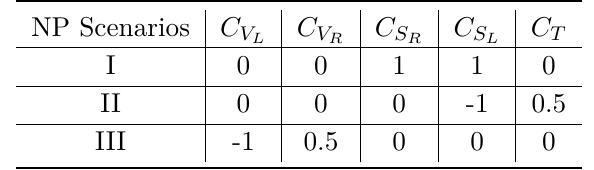
Table 2. Three NP scenarios that we consider to visualize the effect of the NP parameters in the moments. All Wilson coefficients are defined at the scale µ = m